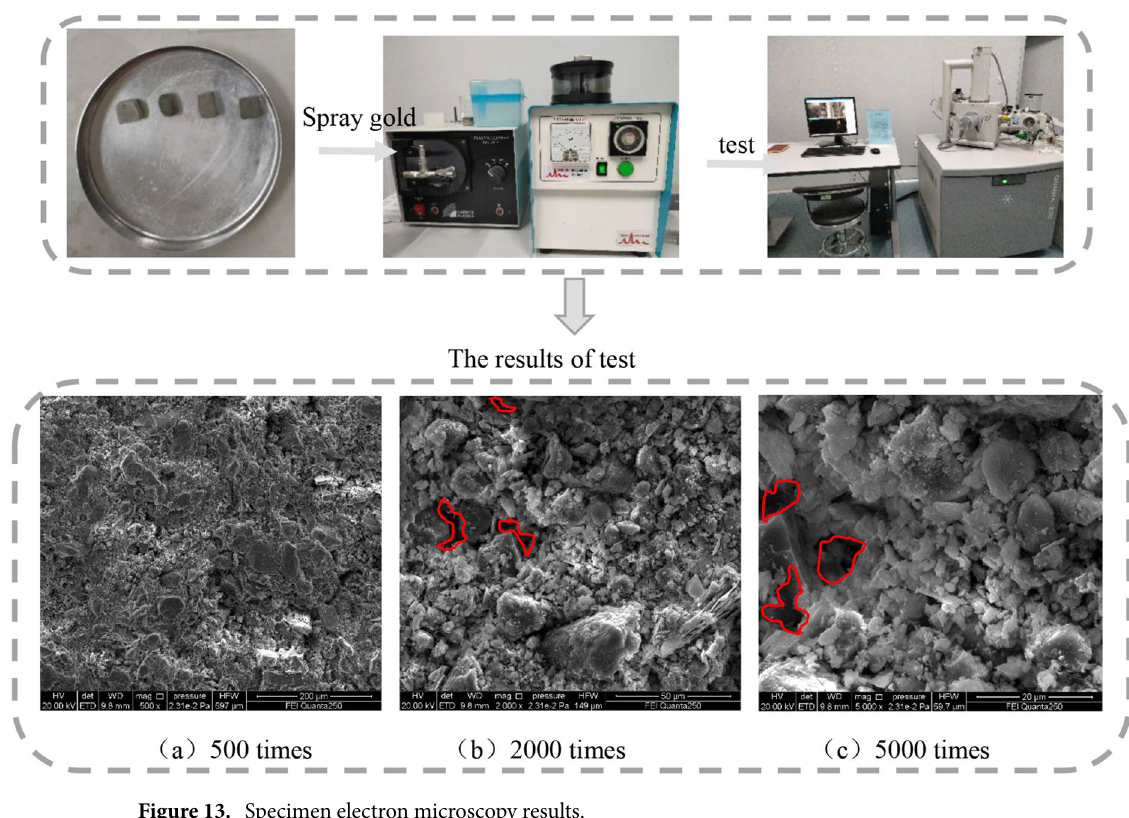
Figure 13. Specimen electron microscopy